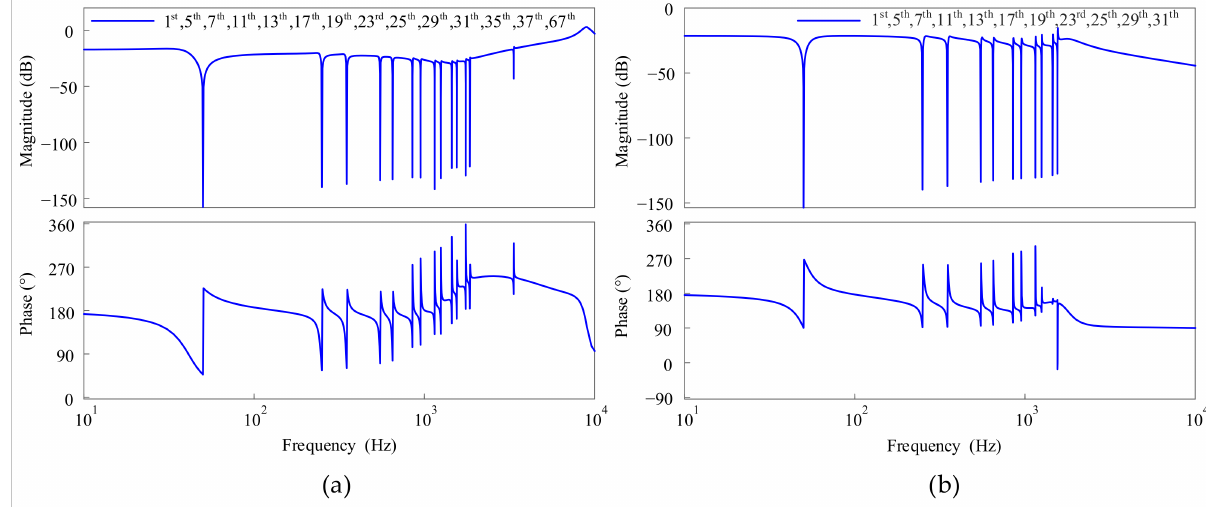
Figure 26. Bode plots of the closed-loop transfer function G vcl_pro ( s ): ( a ) L g = 0; ( b ) L g = 2.6